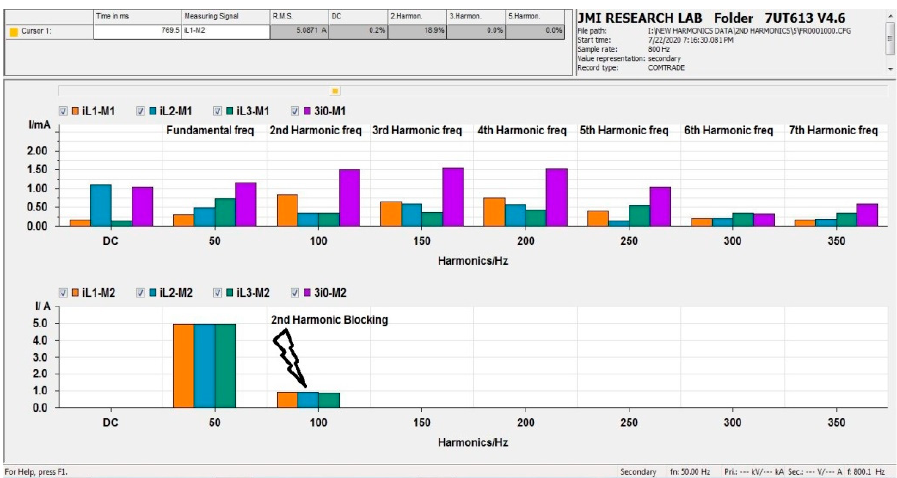
Figure 22. 2nd HB at 5000 mA Rated current & 20% of Inrush current condition.